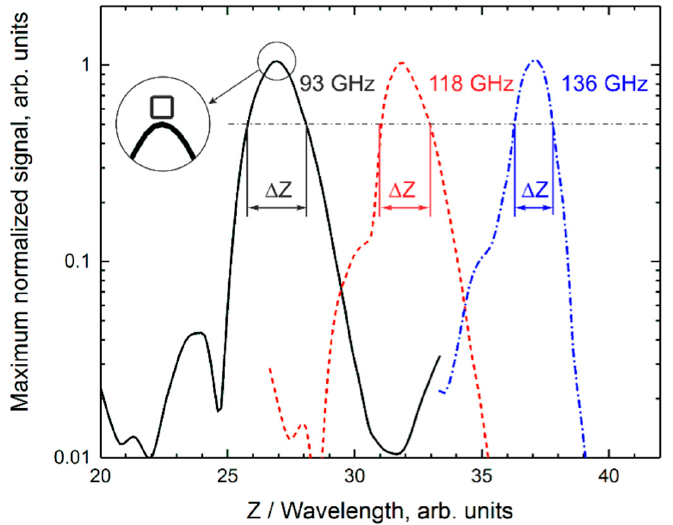
Figure 4. Dependence of MM radiation intensity along the optical Z -axis (shown in Figure 3 by a solid white line) at the frequencies 93, 118, and 136 GHz. The values are normalized to the maximum obtained for each frequency separately. The Z coordinate is normalized to the radiation wavelength. Inset : The photosensitive pad of the pyro-receiver (open square) shown in the scale of the figure data.